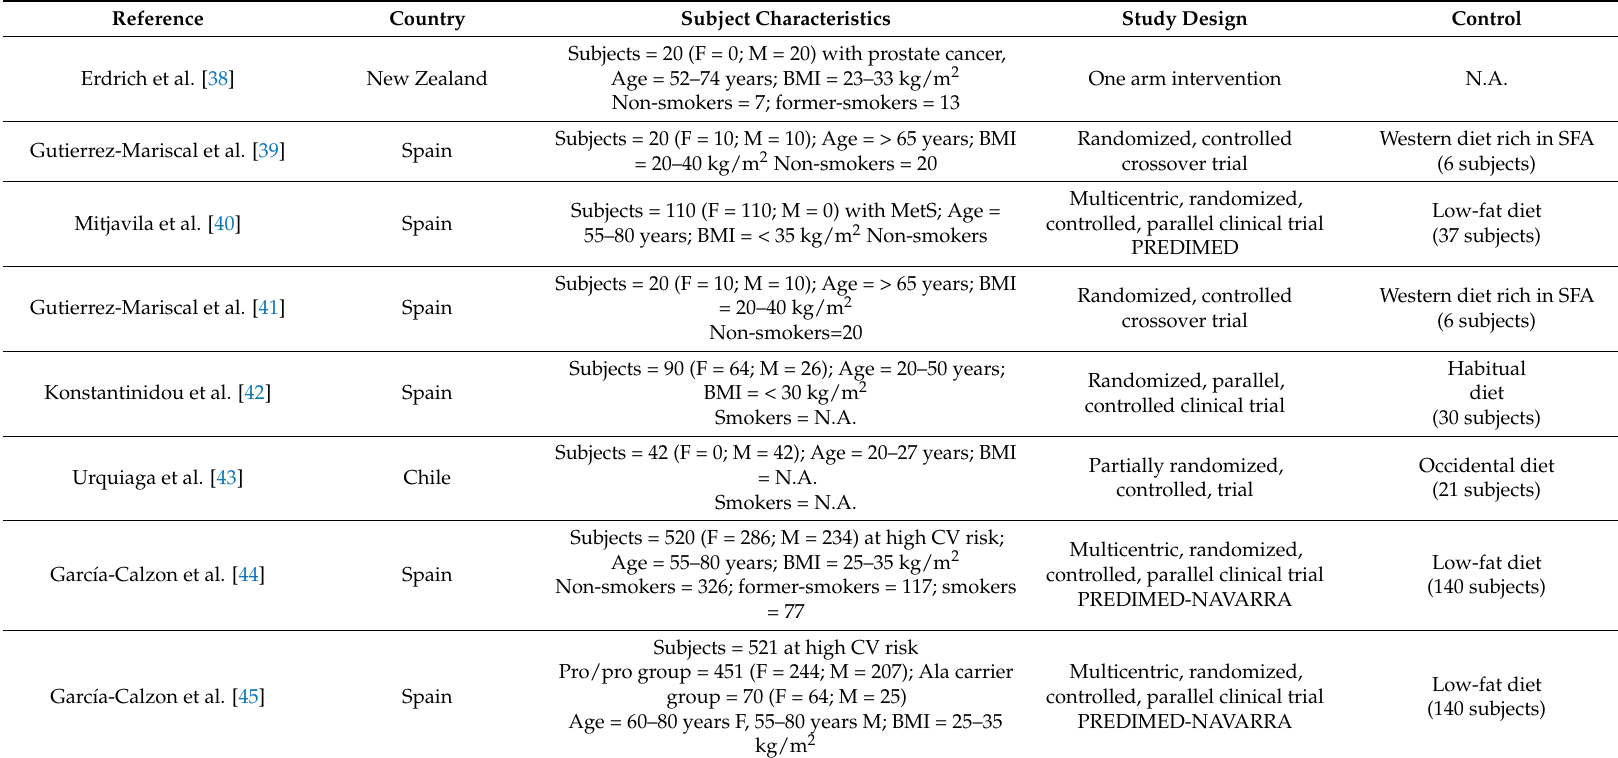
Table 1. Characteristics of the